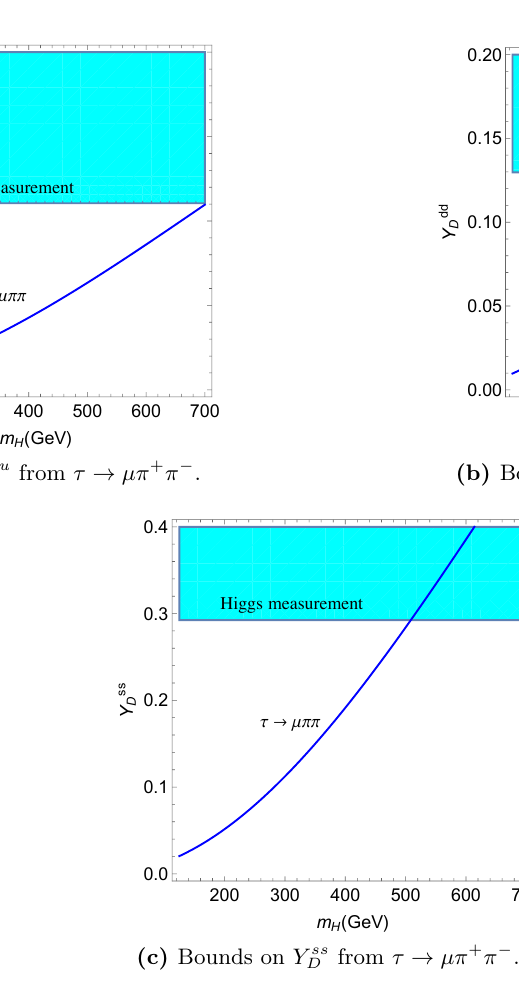
Figure 10. The solid blue lines in these plots show the bounds for Y uu (cid:22)(cid:25) + (cid:25) (cid:0) as a function of m H for Y (cid:28)(cid:22) by the searches. The shaded regions are excluded from the light Higgs precision measurements. In